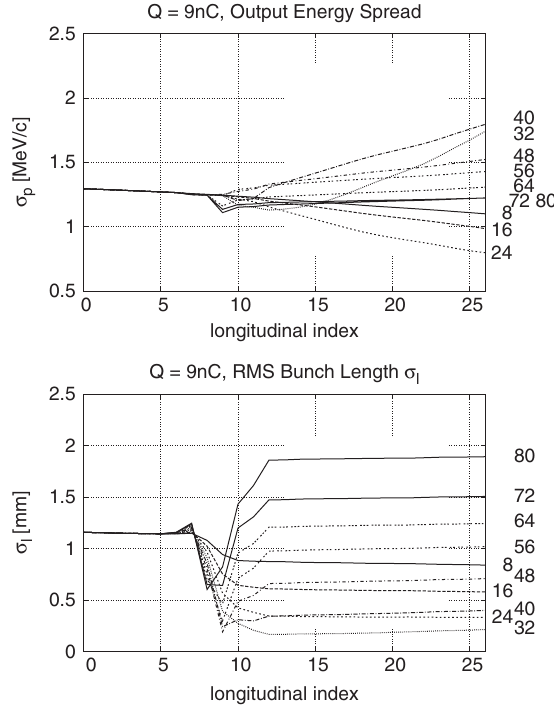
FIG. 6. Dependence on longitudinal position of momentum spread (cid:1) p and bunch length (cid:5) l . To exhibit variation within the first chicane, the horizontal scale is expanded from index location i ¼ 6 to i ¼ 12 . The horizontal scale is uniform from s ¼ 0 at i ¼ 0 to s ¼ 3 : 0 m at i ¼ 6 and from s ¼ 5 : 1 at i ¼ 12 in millimeters are listed to s ¼ 19 : 8 m at i ¼ 26 . Values of R 56 on the